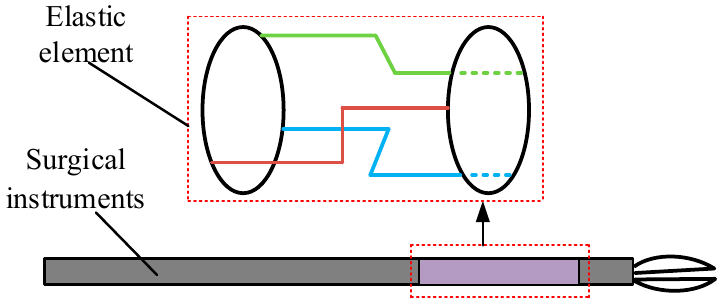
Figure 2. Elastomer element structure diagram.